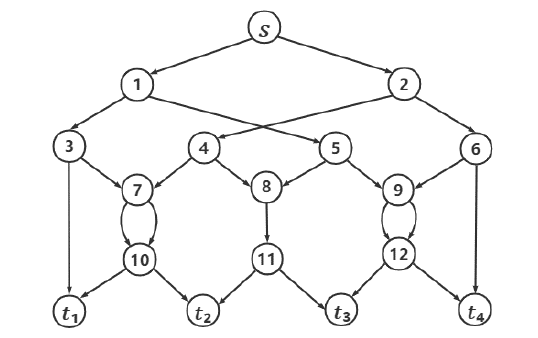
Figure 8. Plot of test function F 2